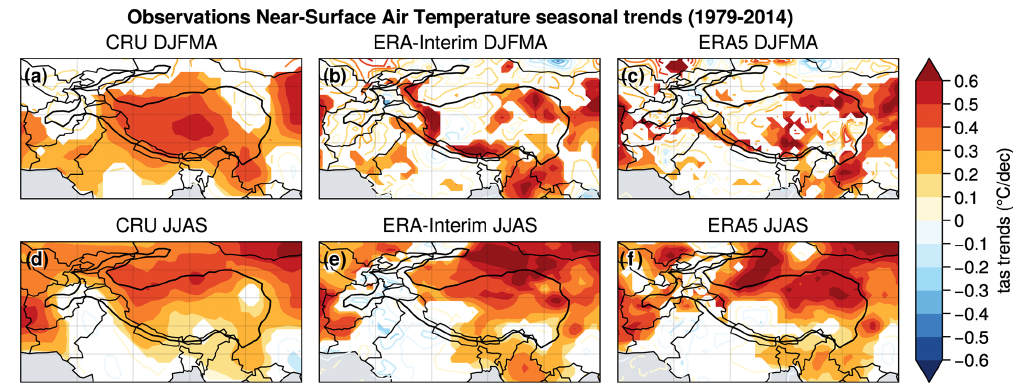
Figure D1. Same as Fig. 7 but for observations and reanalyses comparison with only near-surface air temperature.